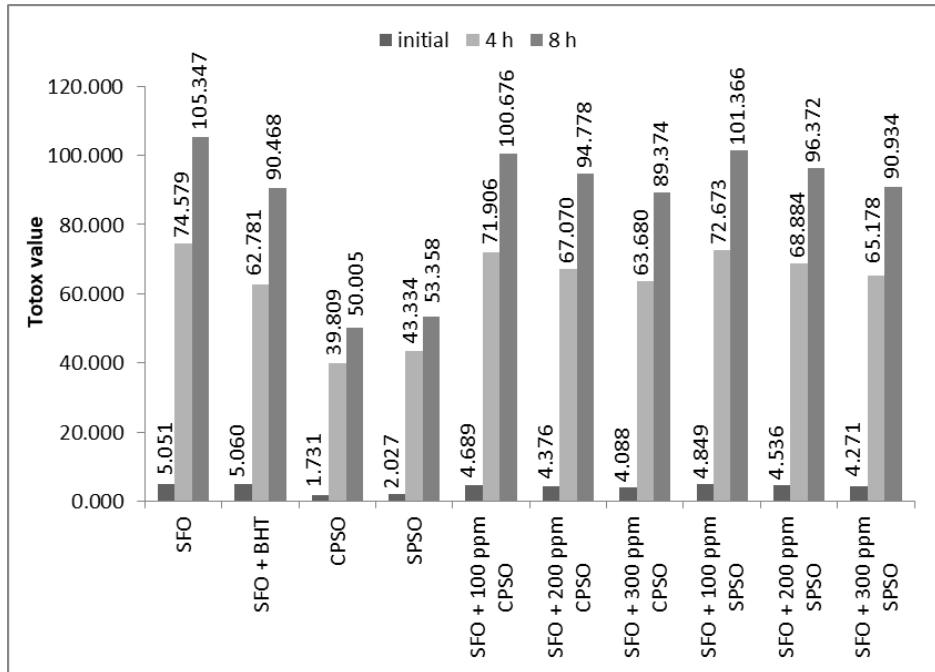
Figure 2. The impact of CPSO, SPSO and BHT on TOTOX value during heating of sunflower oil. The TOTOX values for the samples mixed with BHT, CPSO and SPSO were signifi- cantly lower than the values recorded for the control sample.